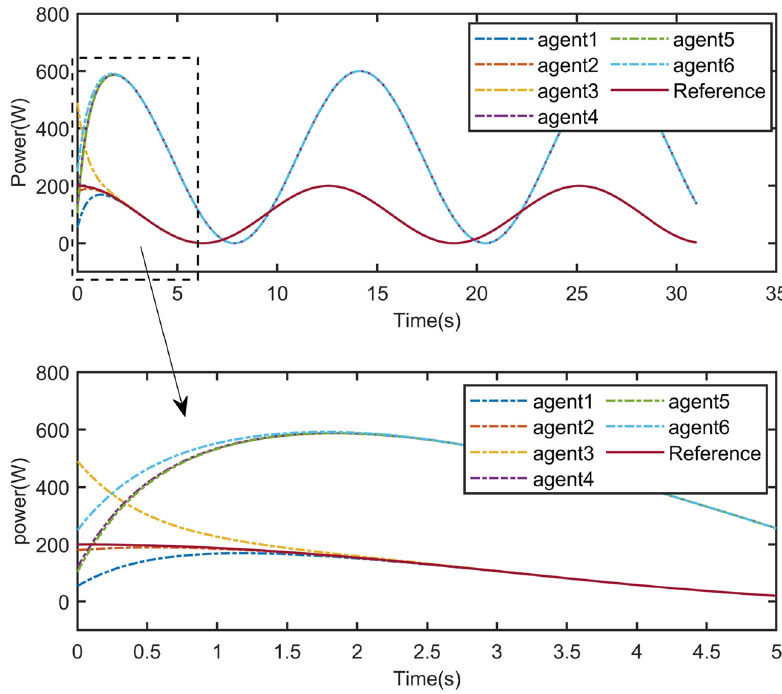
Figure 9: Power consistent output of multi microwave source agent